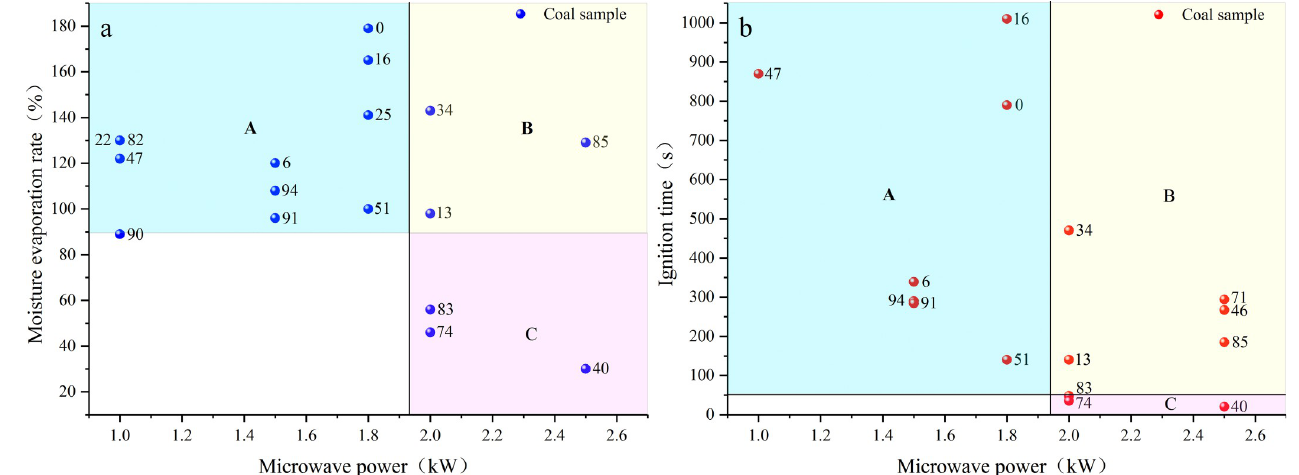
Fig 10. Distribution of moisture evaporation rate and ignition time of water-saturated coal sample.